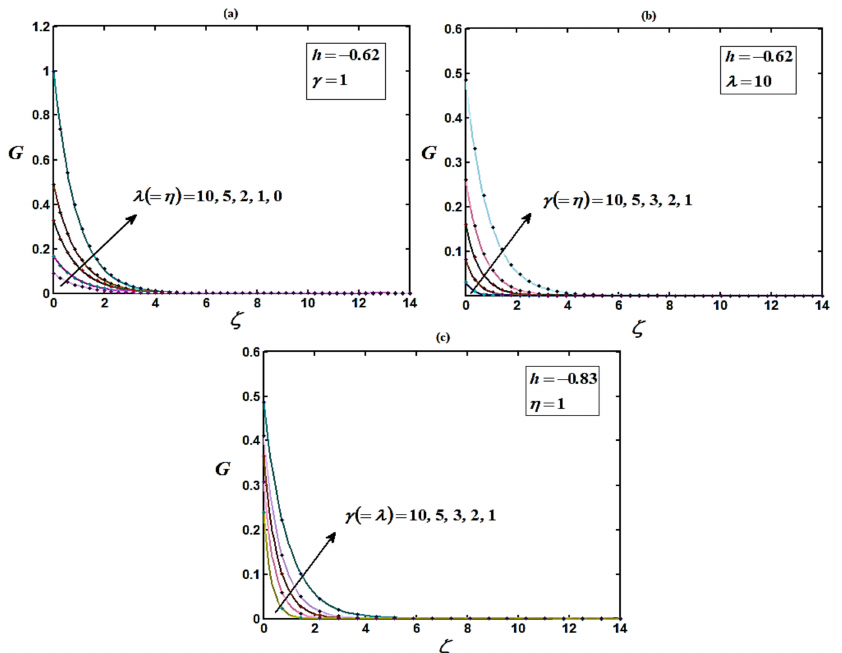
Figure 3. ( a – c ) Plots of the normalized tangential velocity component G versus normalized dis- tance from the disk ζ using Equation (14) for various values of parameters. Solid lines represent Equation (14) and dotted lines represent the numerical solutions [44].